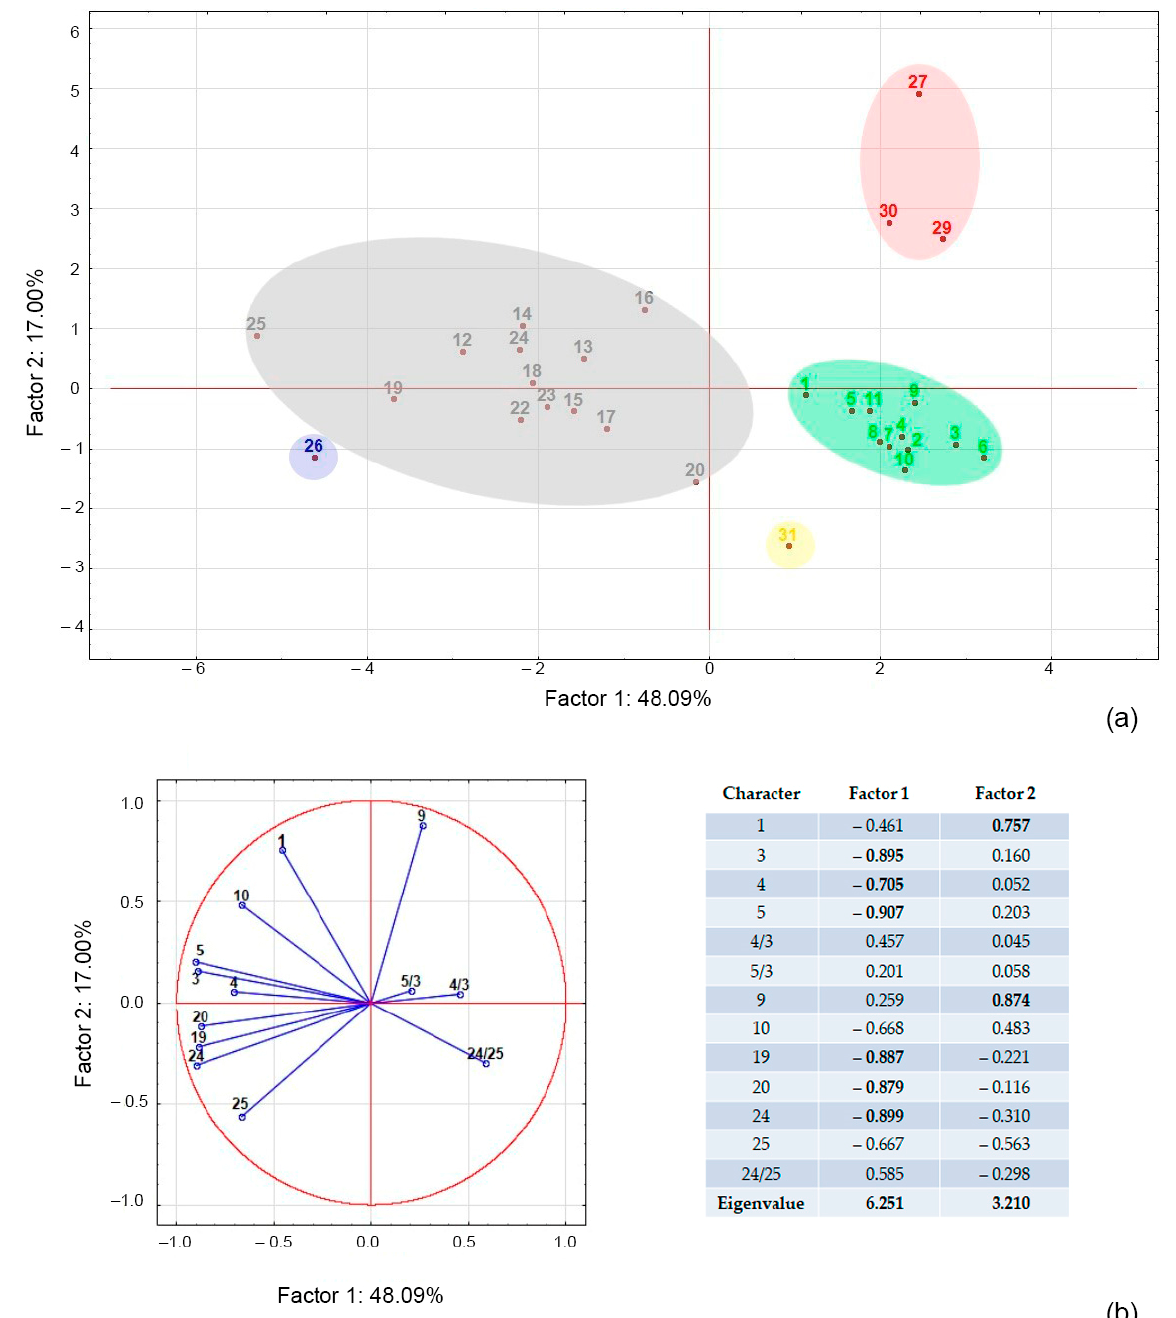
Figure 1. Principal component analysis (PCA) plot of various morphological characters of Nitraria species. ( a ) Scatter plot of various populations represented in two major principal component axes. N. iliensis (red), N. sibirica (green), N. schoberi (grey), N. komarovii (blue) and N. pamirica (yellow). ( b ) Grouping of the variables in two principal components. The most relevant characters of each principal component are shaded. See Table 1 for character number, Table 2 for specimen number. Table 2. Vaucher specimens of Nitraria (Nitrariaceae).